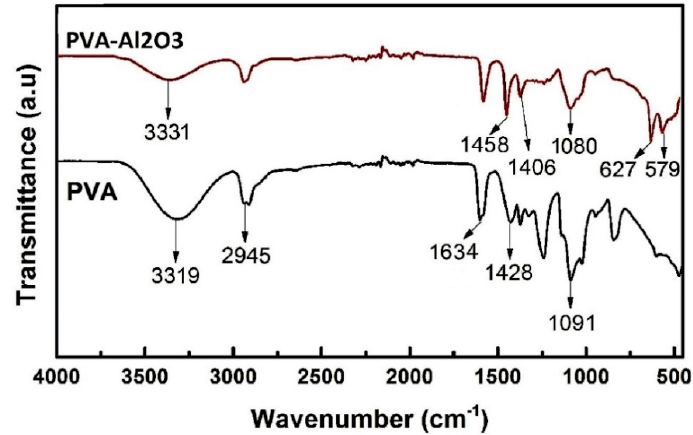
Figure 2. FTIR of original PVA and PVA-Al 2 O 3 (10 wt%) nanocomposite.